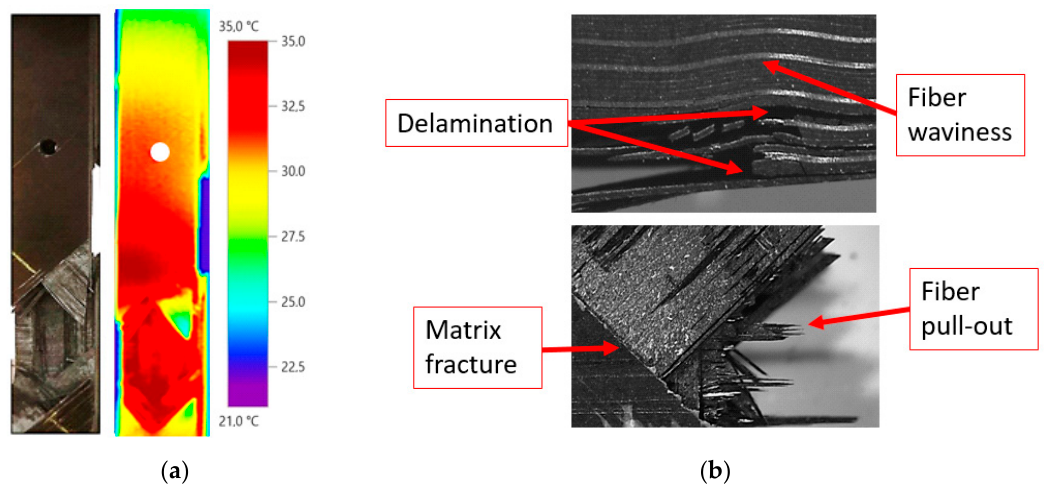
Figure 9. ( a ) Specimen temperature at breakage time for geometry A and ( b ) failure mechanisms observed under optical microscope after breakage.